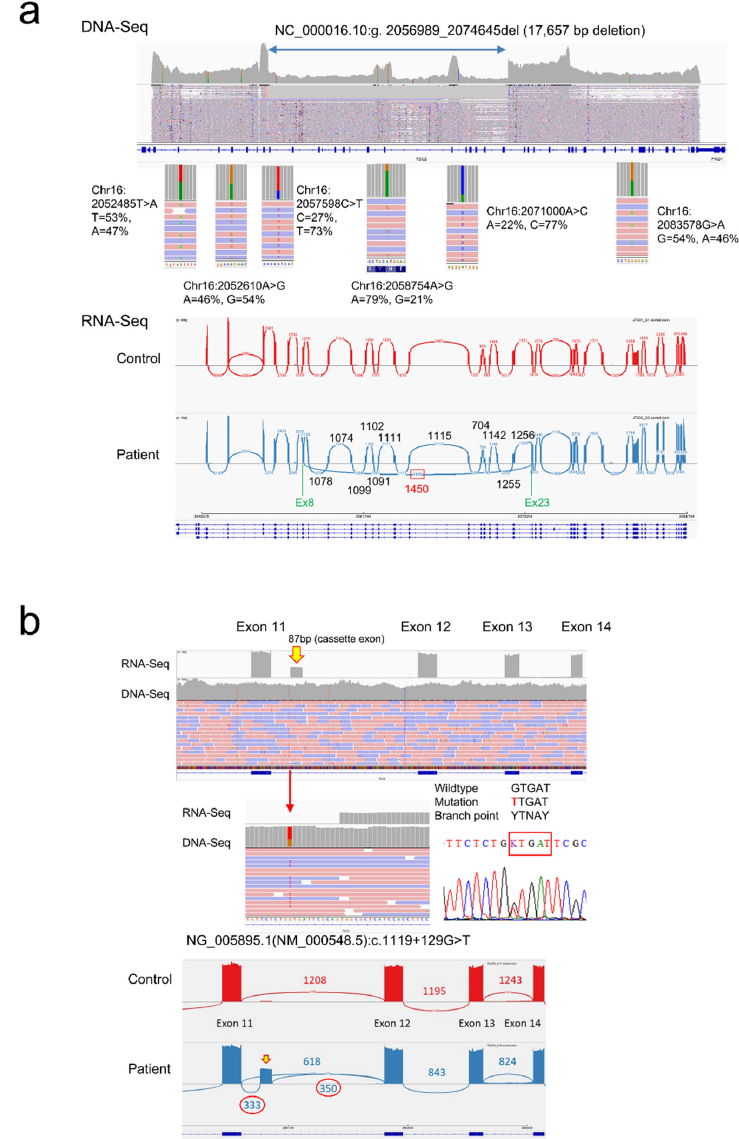
Figure 6. Examples of CoLAS analysis. ( a ) A TSC2 intragenic large deletion was detected in family J2. A large deletion of 17657 bp was confirmed at the DNA level. The deletion site contains heterozygous SNPs, the allelic ratio was biased inside the deletion, and almost 1:1 outside the deletion, indicating that this large deletion was a mosaic mutation. Corresponding to the large deletion, an abnormal junction from exon 8 to 23 was observed at the RNA level. ( b ) A TSC2 deep intronic mutation was detected in family 224. A single base substitution in intron 11 created a new branch point and inserted an 87 base cassette exon. A stop codon appeared within the cassette exon, resulting in a protein-truncating mutation.